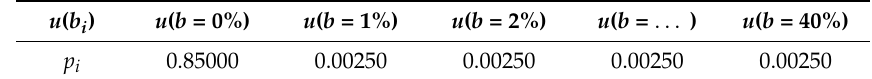
Table 4. The probability values of disruptions in the operation of the S 1 network corresponding to the b discount on the first level.